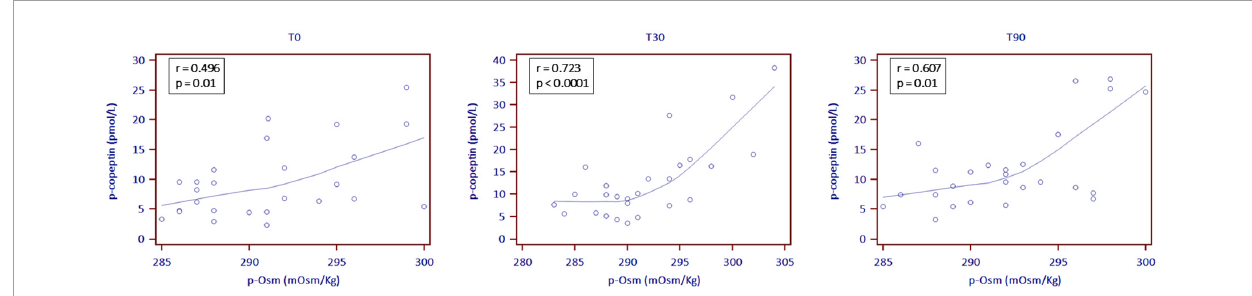
FIGURE2 Correlation between plasma copeptin (p-copeptin) and plasma osmolality levels (p-Osm) the day before the start of SGLT2i (T0) and then at 30 (T30) and 90 (T90) treatment days (locally weighted scattered-pot smoother (LOESS) with a span of 80%).